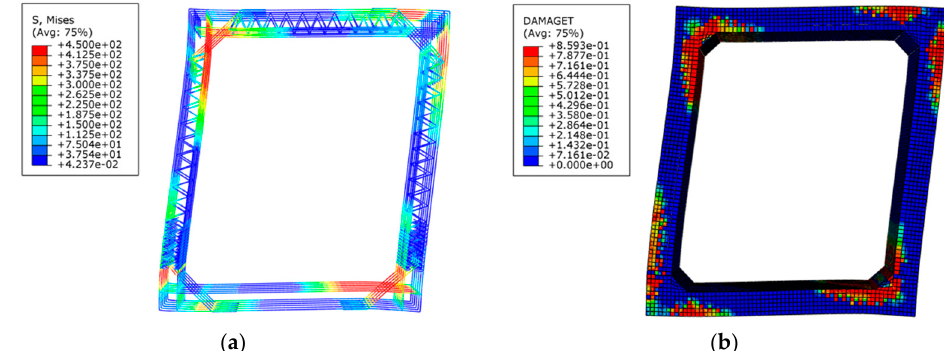
Figure 7. Failure pattern of specimen in FEM. ( a ) Reinforcement stress (MPa); ( b ) Concrete damage factor.